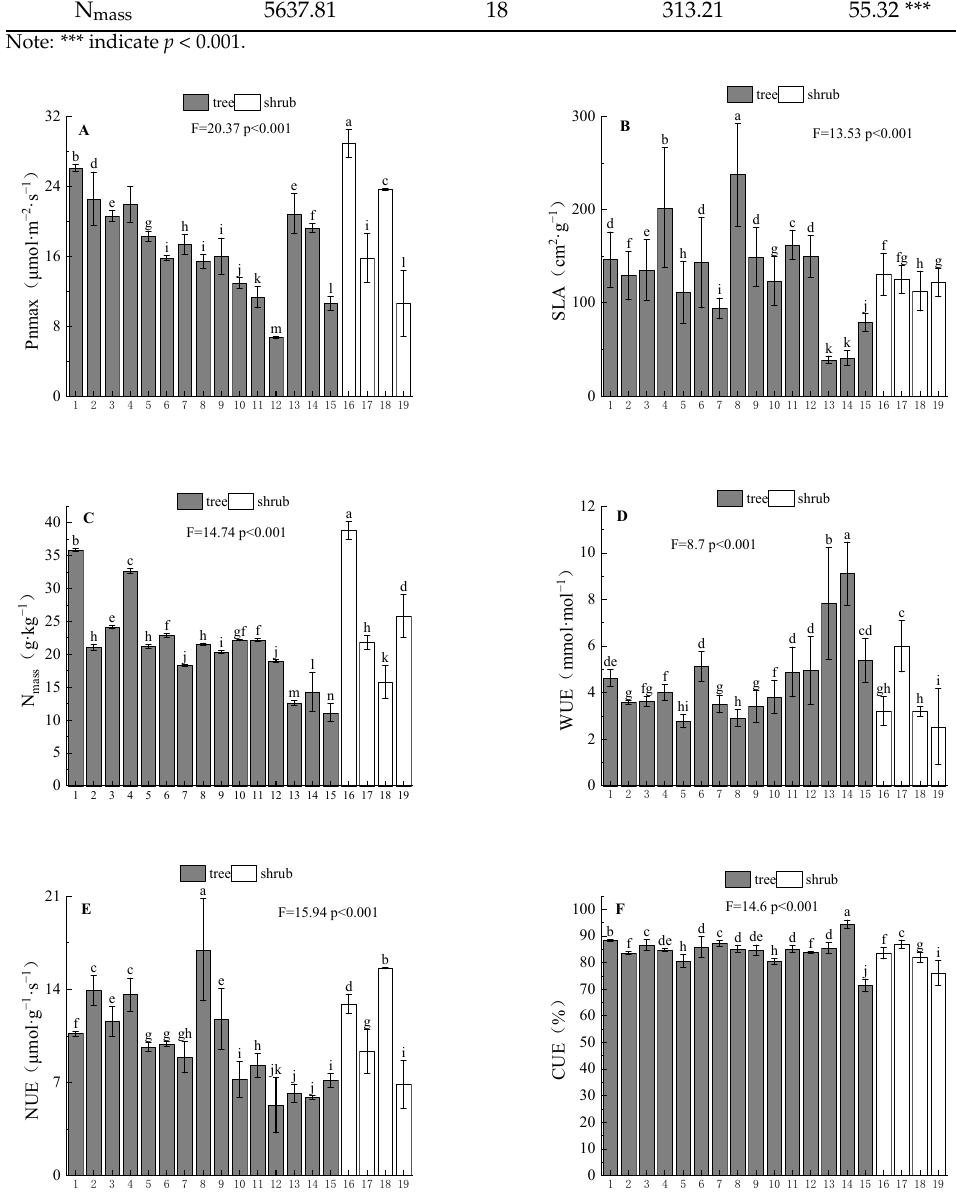
Figure 1. Comparison of mean value of maximum net photosynthetic rate (P nmax , ( A )), specific leaf area (SLA, ( B )), leaf nitrogen content (N mass , ( C )), water use efficiency (WUE, ( D )), nitrogen use efficiency (NUE, ( E )), and carbon use efficiency (CUE, ( F )) among different species (mean ± SE). Different small letters indicate significant difference between life forms for the same resource utilization efficiency ( p < 0.05).